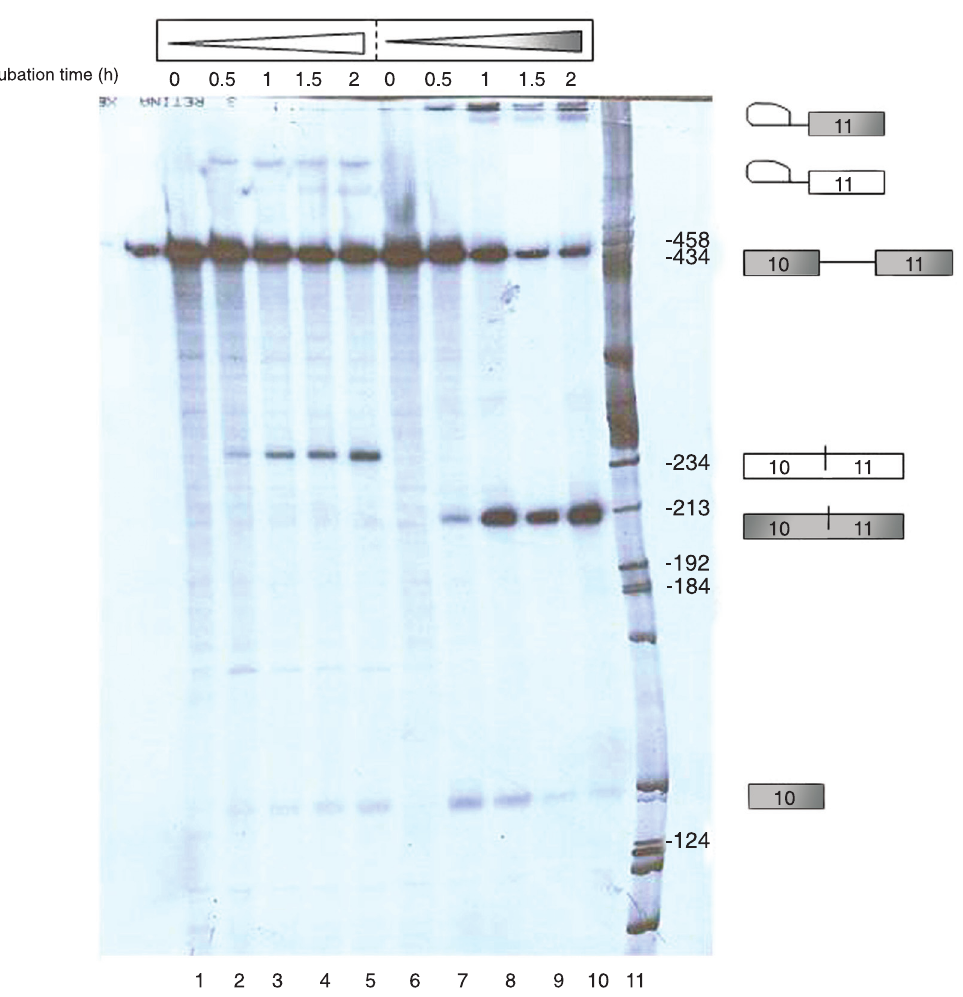
Figure 2. Time course of the in vitro splicing reaction of the wild-type AhR-10 ( lanes 6-10 ) and the mutant AhR-10 ( lanes 1-5 ) constructs in HeLa cell nuclear extracts. Lanes 1 and 6 = incubation time in HeLa cell nuclear extract 0 h; lanes 2 and 7 = 0.5 h; lanes 3 and 8 = 1 h; lanes 4 and 9 = 1.5 h; lanes 5 and 10 = 2 h. Lane 11 = RNA size marker. Ahr = aryl hydrocarbon